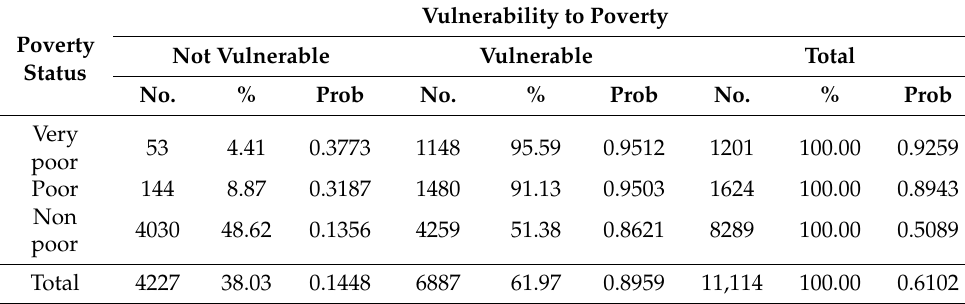
Table 3. Vulnerability without Social Expenditure, 2016/2017.